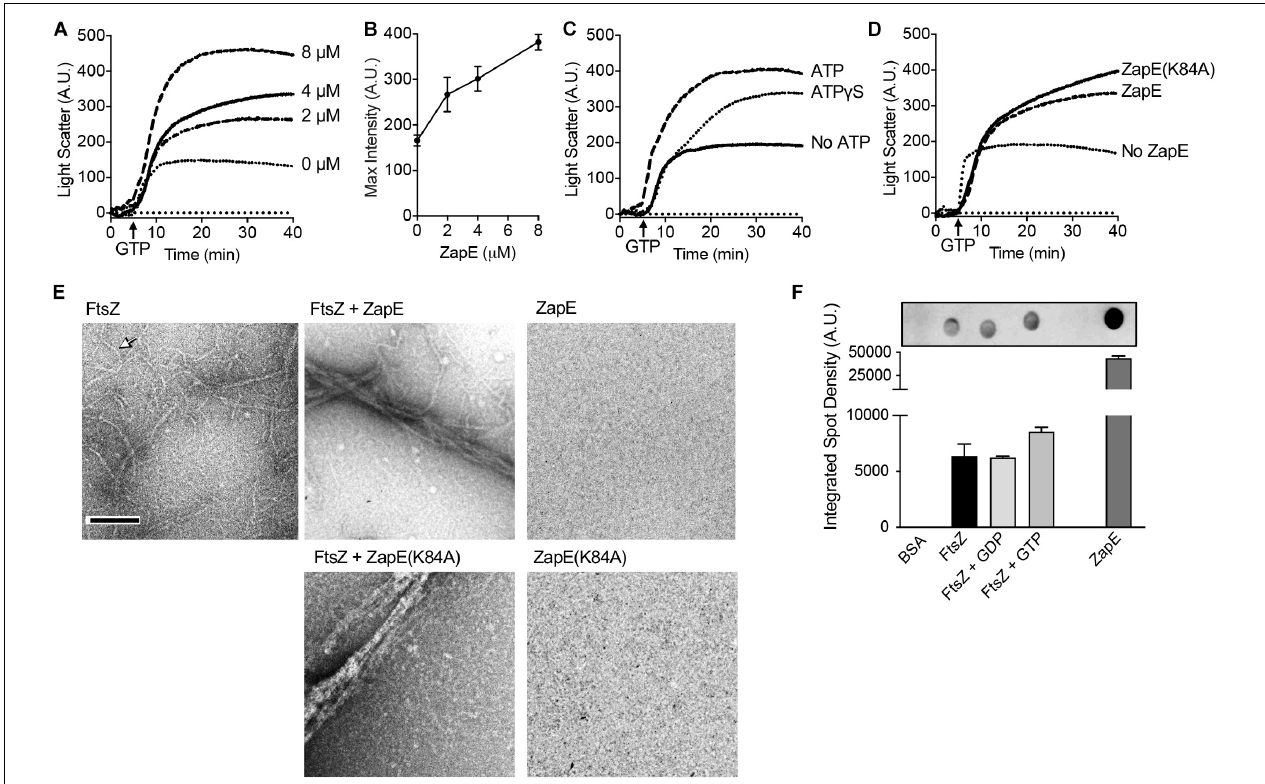
FIGURE 2 | ZapE promotes FtsZ polymer bundling. (A) GTP-dependent assembly of complexes containing FtsZ was monitored by 90 ◦ light scattering, as described in Materials and methods section. FtsZ (8 µ M) was incubated with increasing concentration of ZapE (0 to 8 µ M) in the presence of ATP (4 mM). After collecting a baseline for 5 min, GTP (1.5 mM) was added to stimulate FtsZ polymerization and light scatter was monitored over time. (B) Maximum intensity (A.U.) values after addition of GTP in (A) for light scattering reactions containing FtsZ (8.0 µ M) and increasing concentrations of ZapE titration (0, 2.0, 4.0, and 8.0 µ M) and ATP (4 mM). Data shown are the average of at least three replicates represented as mean ± SEM. (C) Light scattering assay showing reactions containing FtsZ (8.0 µ M) and ZapE (8.0 µ M) in the absence or presence of ATP (4 mM) or ATP G S (2 mM). Data shown are representative of at least three replicates. (D) Light scattering assay showing reactions containing FtsZ (8 µ M), assembled with GTP (1.5 mM) in the absence and presence of ZapE (4 µ M) or ZapE(K84A) (4 µ M) with ATP (4 mM). Data shown are representative of at least three replicates. (E) ZapE (8 µ M) or ZapE(K84A) (8 µ M) were incubated with ATP (4 mM) and, where indicated, FtsZ (8 µ M) and GTP (1.5 mM). Reactions were incubated for 15 min at 23 ◦ C and then visualized by transmission electron microscopy (TEM) as described in Materials and methods section. Size bars are 200 nm. Arrow indicates an FtsZ polymer. (F) Binding of ZapE to FtsZ was assayed by dot blot. Bovine serum albumin (BSA) (10 µ M), ZapE (10 µ M), and FtsZ (10 µ M) alone or with GDP (2 mM) or GTP (2 mM) were spotted (3 µ l) onto a nitrocellulose membrane and then membranes were blocked, incubated with ZapE (8 µ M) and ATP (4 mM) to allow binding, and then probed with antibodies to ZapE. Spot densities were quantified by NIH ImageJ. Data shown are the average of at least three replicates represented as mean ±